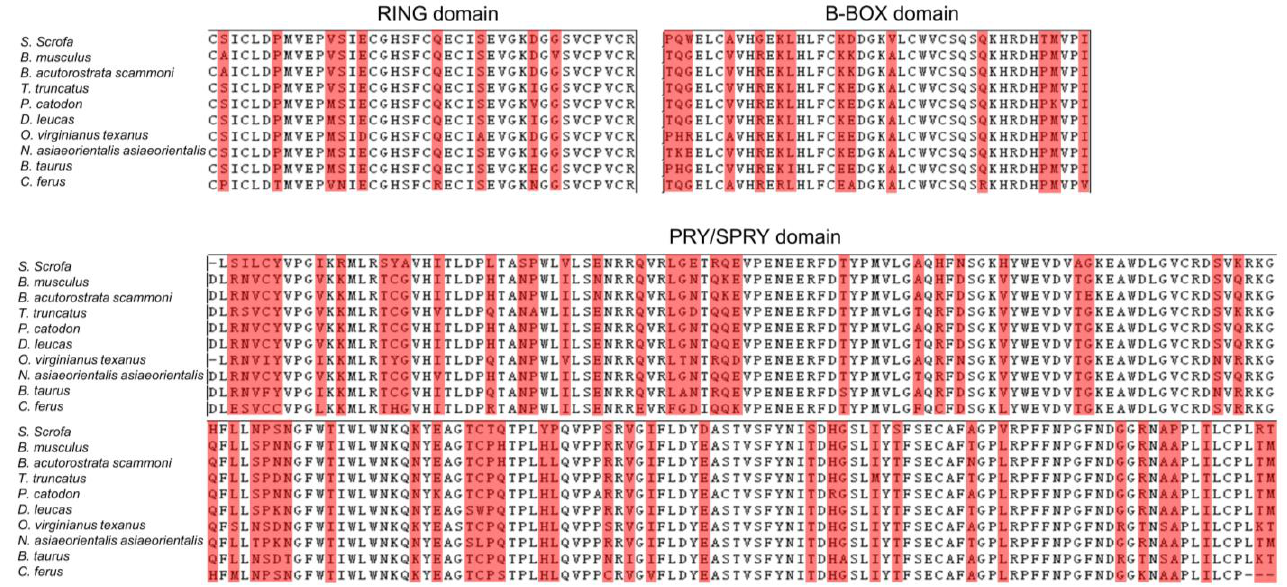
Figure 4. Comparison of TRIM21 derived from swine and eight other species. The conserved residue is labeled in white. Red indicates different amino acids.